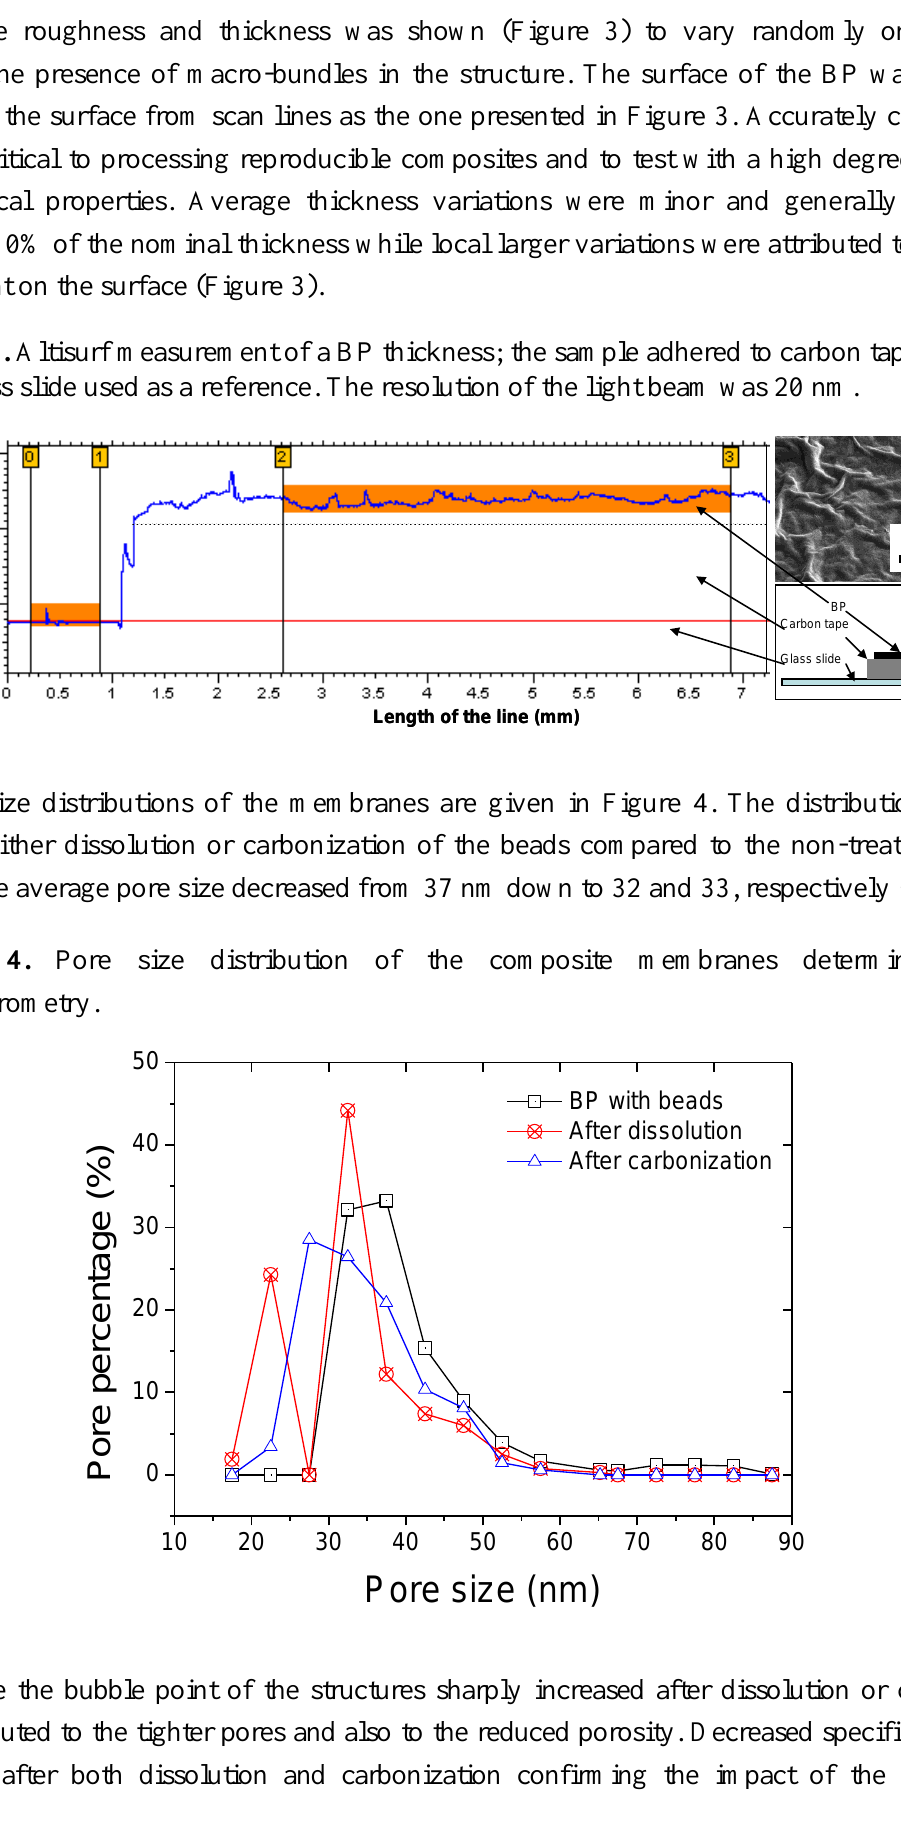
Figure 3. Altisurf measurement of a BP thickness; the sample adhered to carbon tape, and on a glass slide used as a reference. The resolution of the light beam was 20 nm.